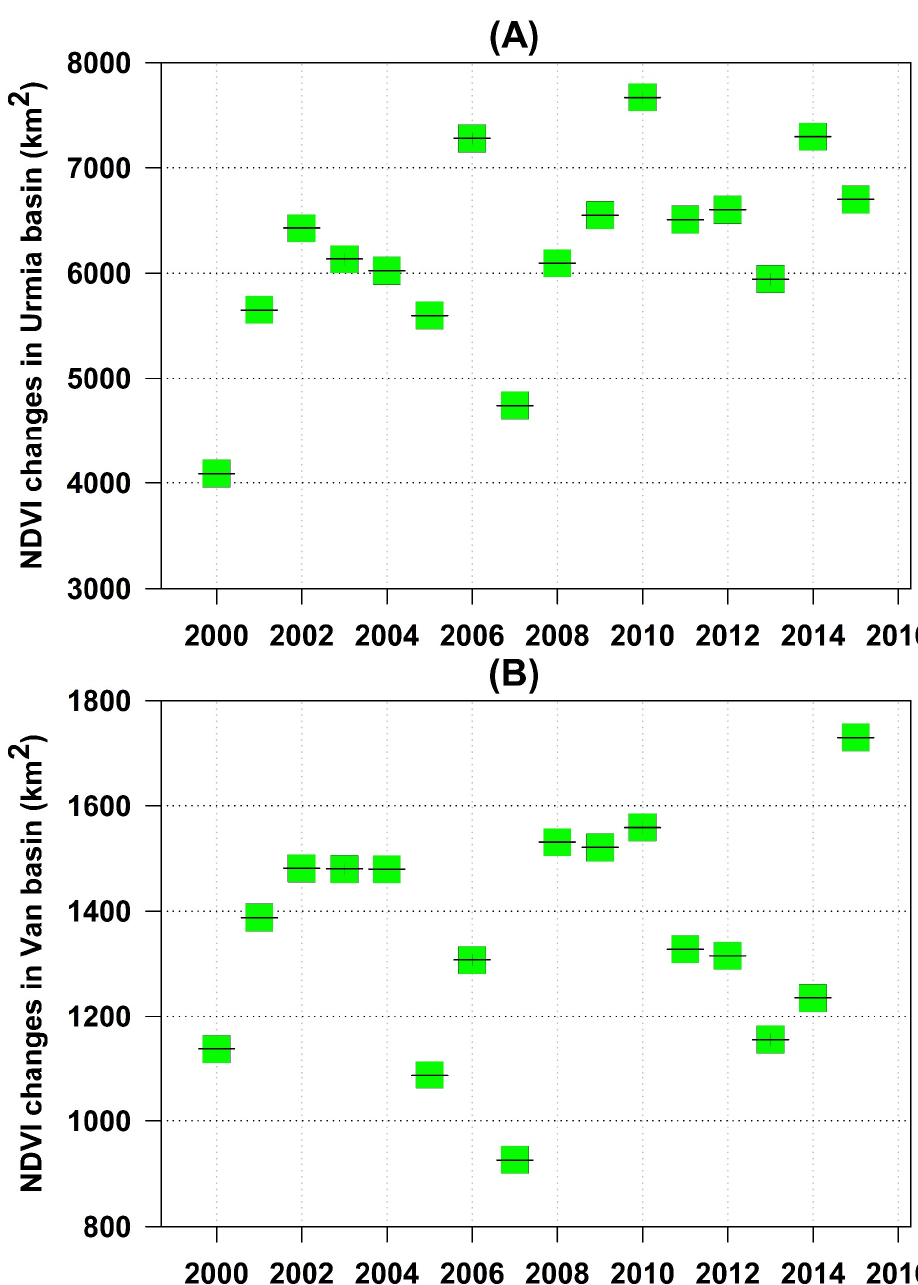
Figure 8. NDVI changes and its trends in the basins of LU ( A ) and LV ( B ). Nonetheless, NDVI levels in the LU basin stabilized from 2012 to 2013, in the LV basin